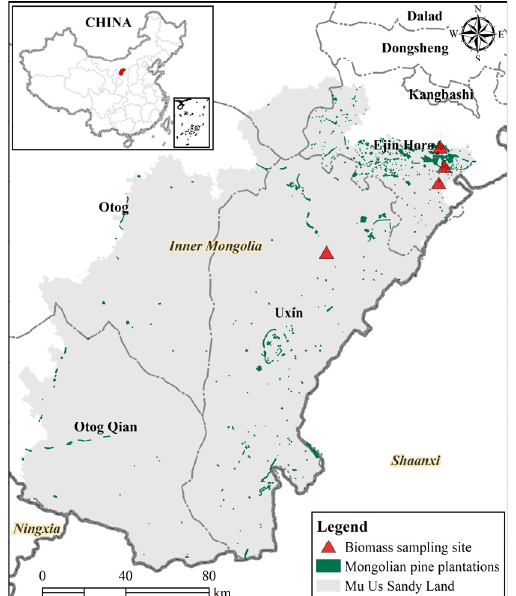
Figure 1. The geographical location of the study area and biomass sampling sites in Mongolian pine plantations in the Mu Us Sandy